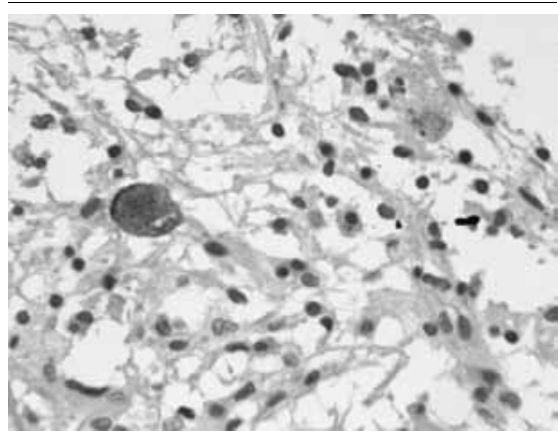
figurE 3 – Ganglion cell immunostained with NF with granular cytoplasm in pleomorphic xanthoastrocytoma (lens 40×) NF: neurofilament.